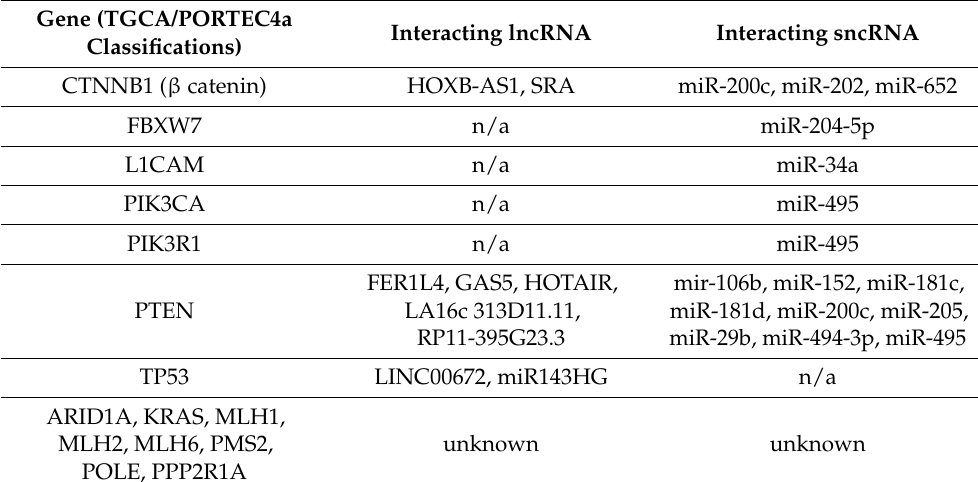
Table 3. ncRNA which functionally interact with EC diagnostic and prognostic genes. Gene